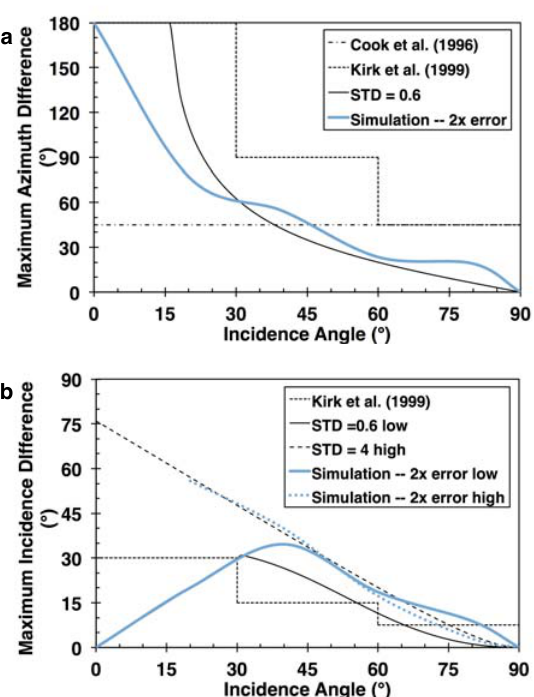
Figure 8. Proposed criteria (black lines) for acceptable limits on (a) sun azimuth mismatch and (b) incidence angle mismatch for stereo matching. Blue lines show the angular differences at which our simulations indicate 2x